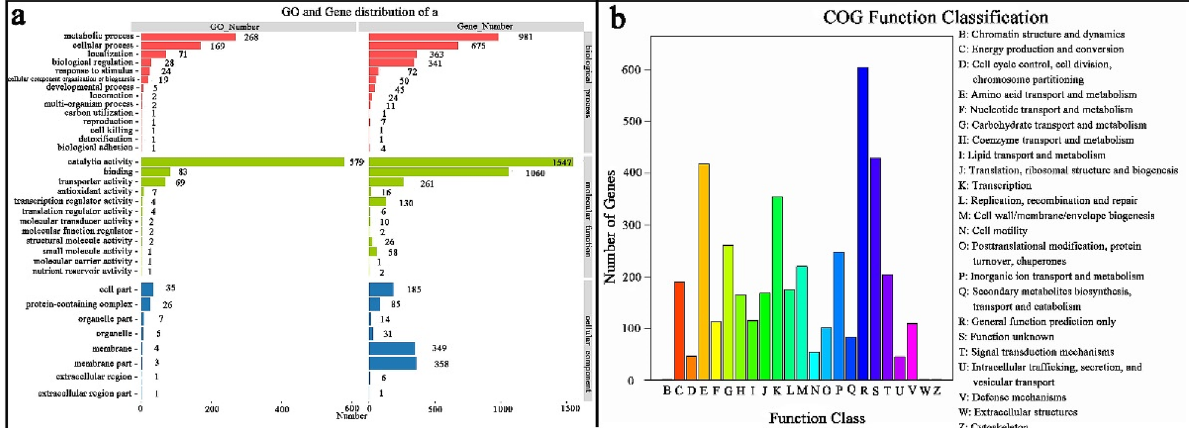
Figure 3. ( a ) GO function classification of Bacillus sp. TK-2. The X-axis is the number of genes, Y-axis is GO term, and different colors are used to distinguish biological processes, cell components, and molecular functions. ( b ) COG functional classification of genes, the X-axis is the functional classification of COG, the Y-axis is the number of genes annotated in each classification, and the explanation of each classification is marked on the right side of ( b